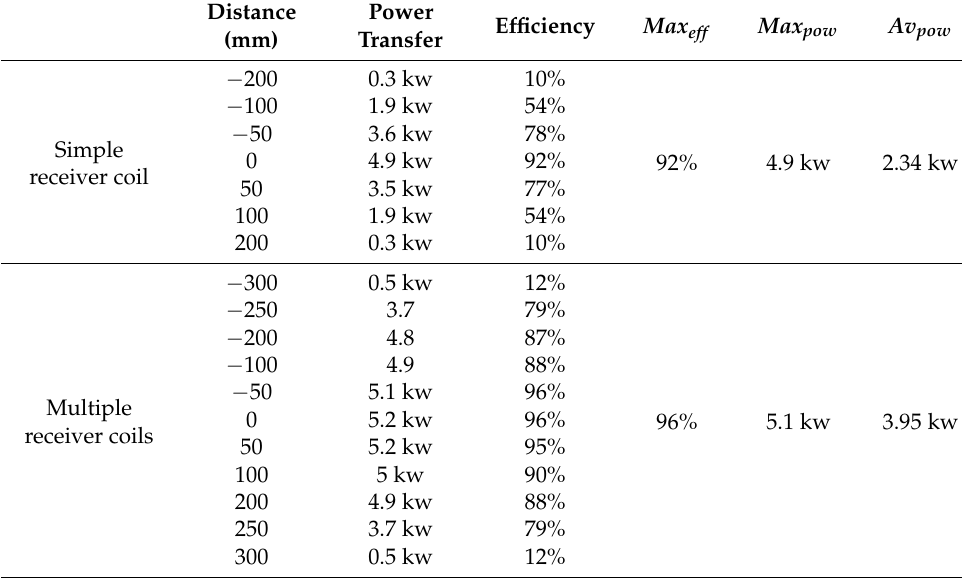
Table 3. Power transfer factor for the case of one or two receivers